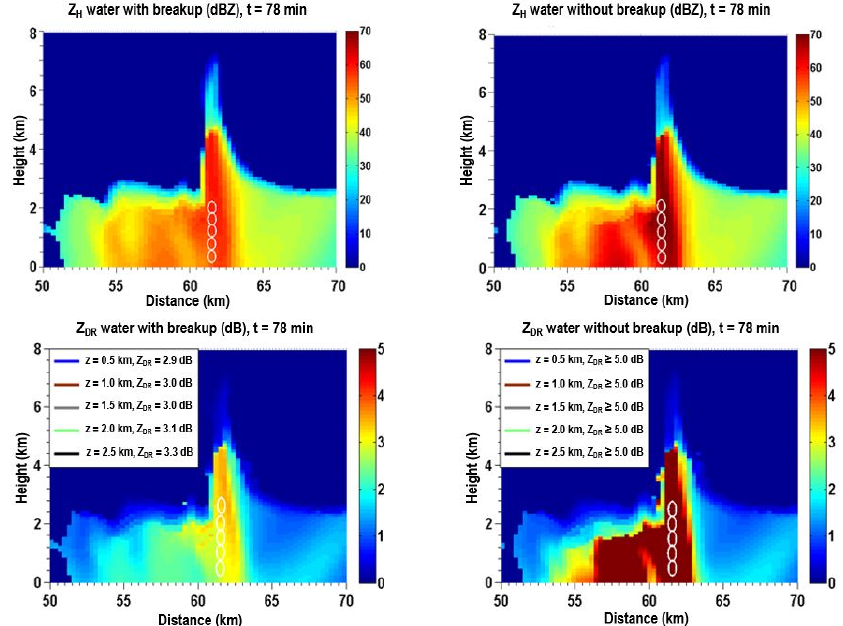
Figure 7. Fields of ( top ) Z and ( bottom ) Z DR at the C band in a hailstorm simulated with ( left ) and without ( right ) spontaneous raindrop breakup. Adapted from Ilotoviz et al. [77].